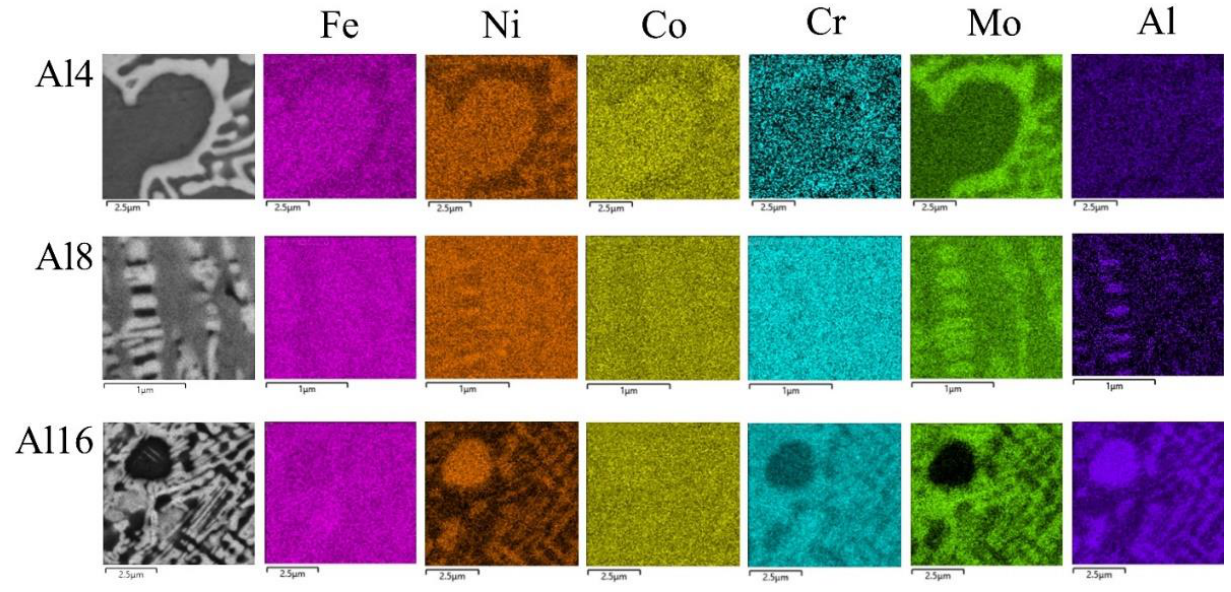
Figure 3. Elemental distribution in the Al4, Al8, and Al16 alloys.